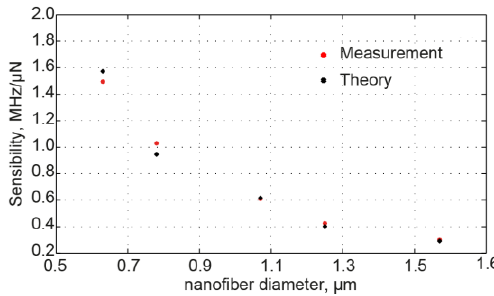
Fig. 1. Brillouin sensitivity as a function of the nanofiber diameter, experiment (red) and theory